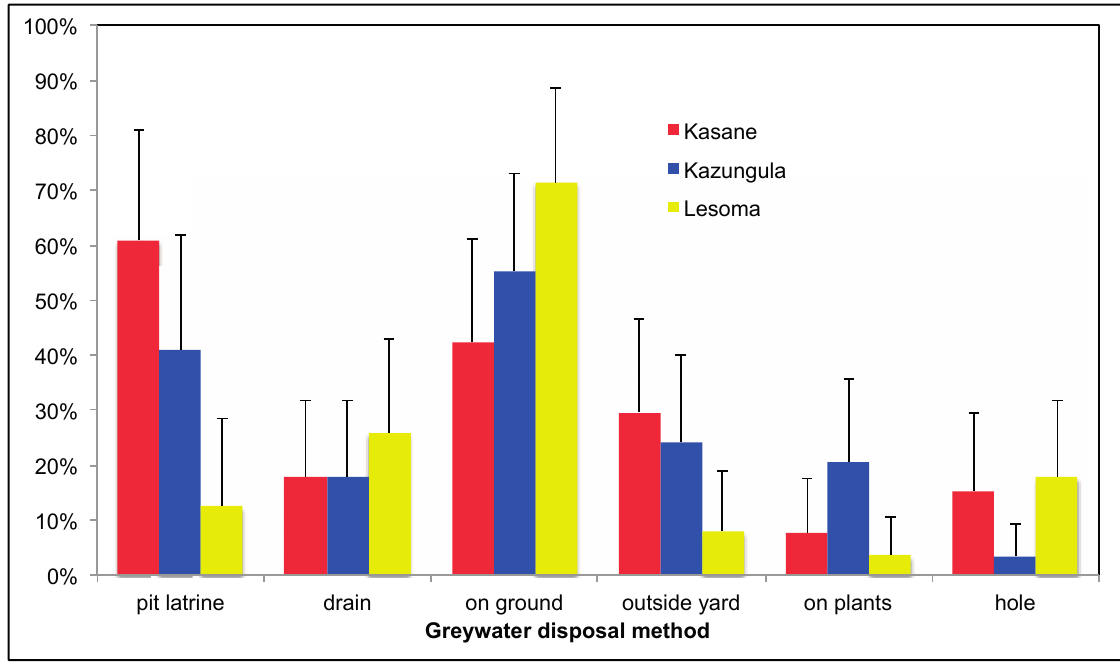
Figure 2. Greywater disposal varied by villages but dumping of greywater into the pit latrine was a practice found in all villages, particularly Kasane, where residential density was highest. While not statistically significant, there was a reverse trend for ground disposal of greywater to be higher in villages with lower density such as Kazungula and